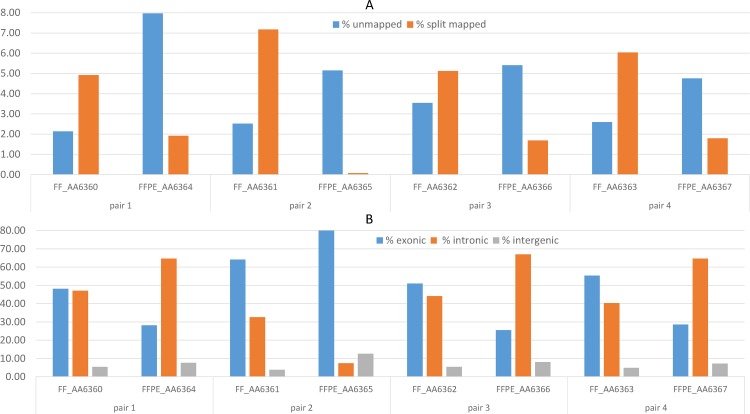
Mapping results in FFPE and matched FF tissue samples.(A) Percentages of unmapped reads and split-mapped reads in FFPE and FF samples. (B) Percentages of paired-end reads mapping to exonic, intronic or intergenic regions.